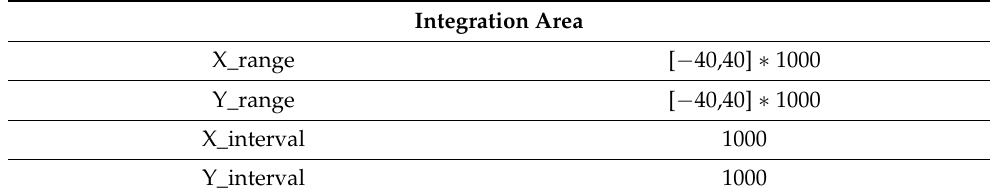
Table 2. Integration area settings.